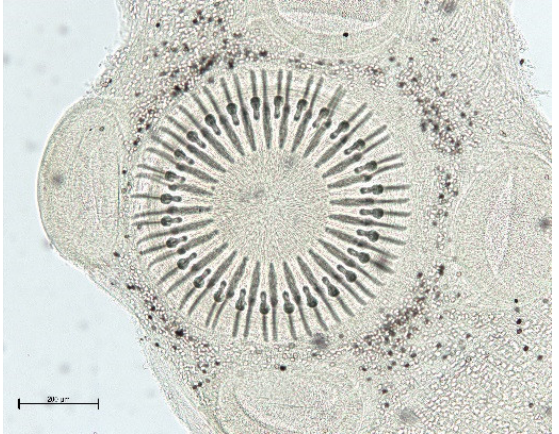
Figure 13. T. polyacantha scolex. Bar: 200 μm.